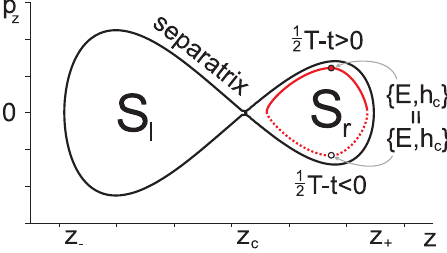
Fig. A4. Schematic presentation of calculation of the integral R (T/ 2 − t) { E,h c } d t